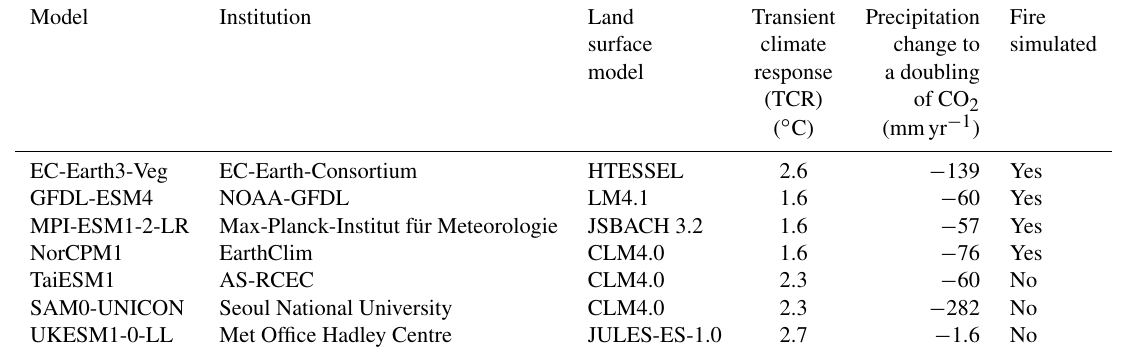
Table 1. CMIP6 models used within this study (Nijsse et al., 2020; Döscher et al., 2022; Arora et al., 2020; Tokarska et al., 2020; Wang et al.,